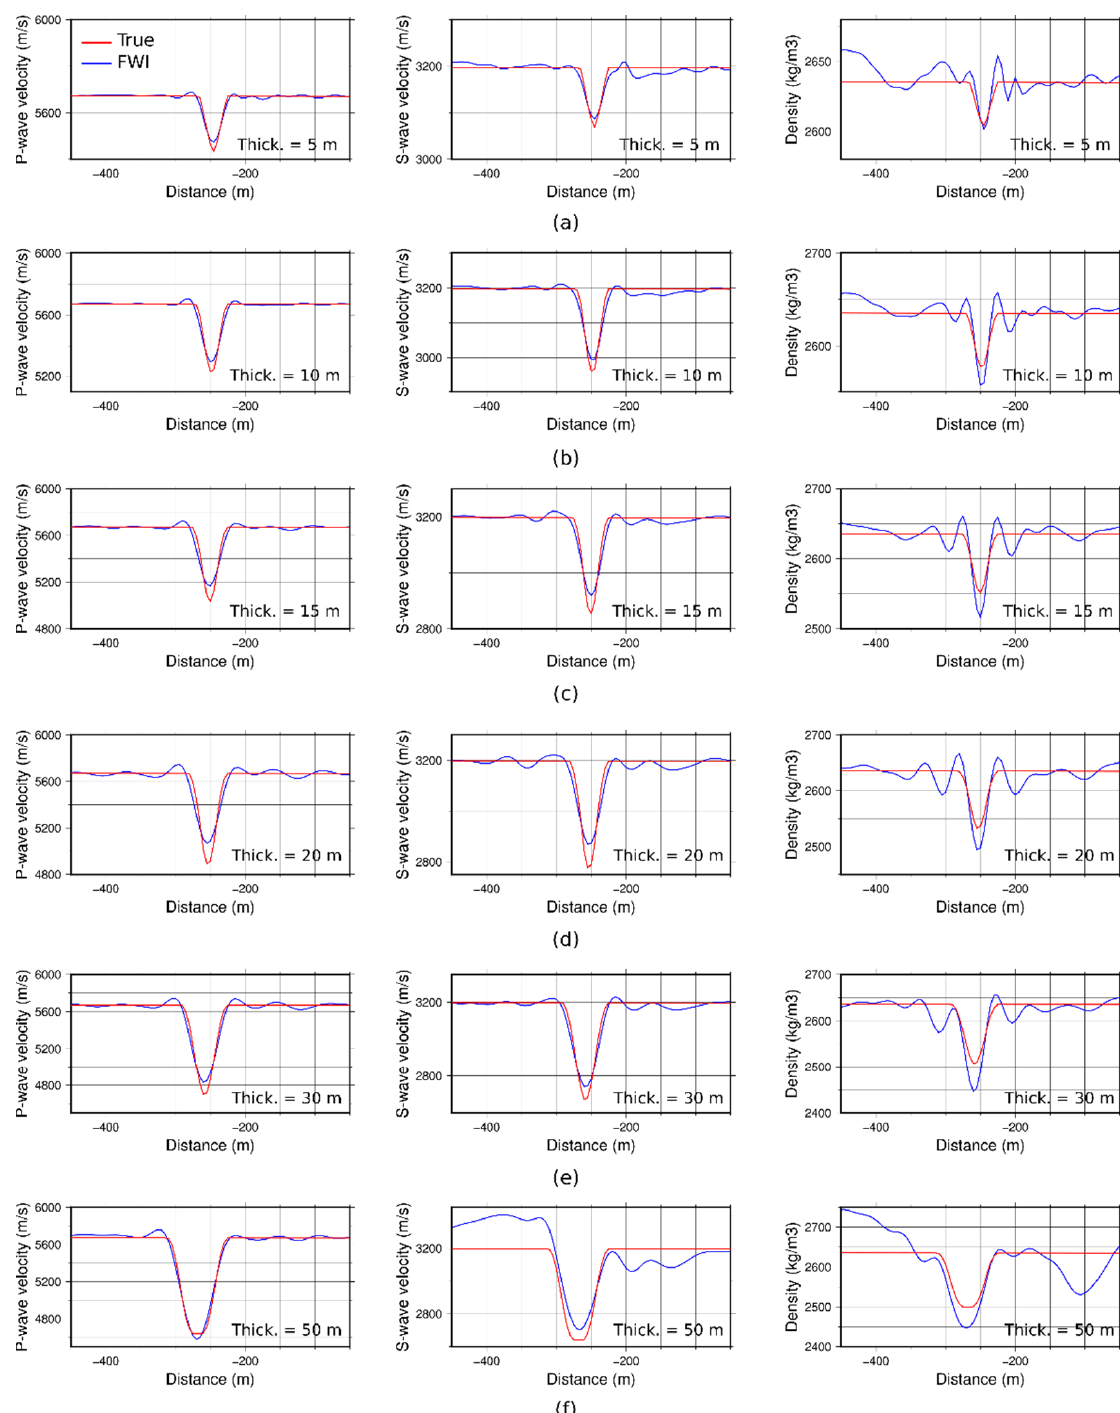
Figure 14. Estimated physical parameter values as a function of the distance for several fault thickness at 2800 m depth. The estimated P-wave (left), S-wave (middle) and density (right) from FWI for fault thicknesses; ( a ) 5 m, ( b ) 10 m, ( c ) 15 m, ( d ) 20 m, ( e ) 30 m and ( f ) 50 m. The estimations are good to very good but some artefacts are present in density curves, for instance, panels c-e. Surprisingly, the FWI provides accurate and precise fault characterization even for faults as thin as 5 or 10 m (a and